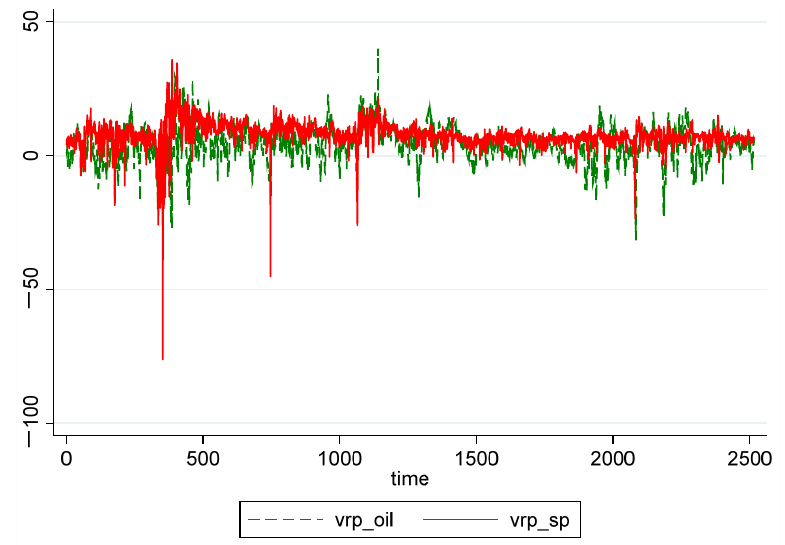
Figure 2. VRP oil and VRP sp from 10 May 2007 to 16 May 2017. Notes: Daily volatility risk premium of oil (VRP oil ) and stock (VRP sp ) from 10 May 2007 to 16 May 2017. The vertical axis represents their values and time in the horizontal axis represents the date where time 1 corresponds to 10 May 2007, time 500 to 13 May 2009, time 1000 to 6 May 2011, time 1500 to 3 May 2013, time 2000 to 29 April 2015, and time 2500 to 24 April 2017, respectively.